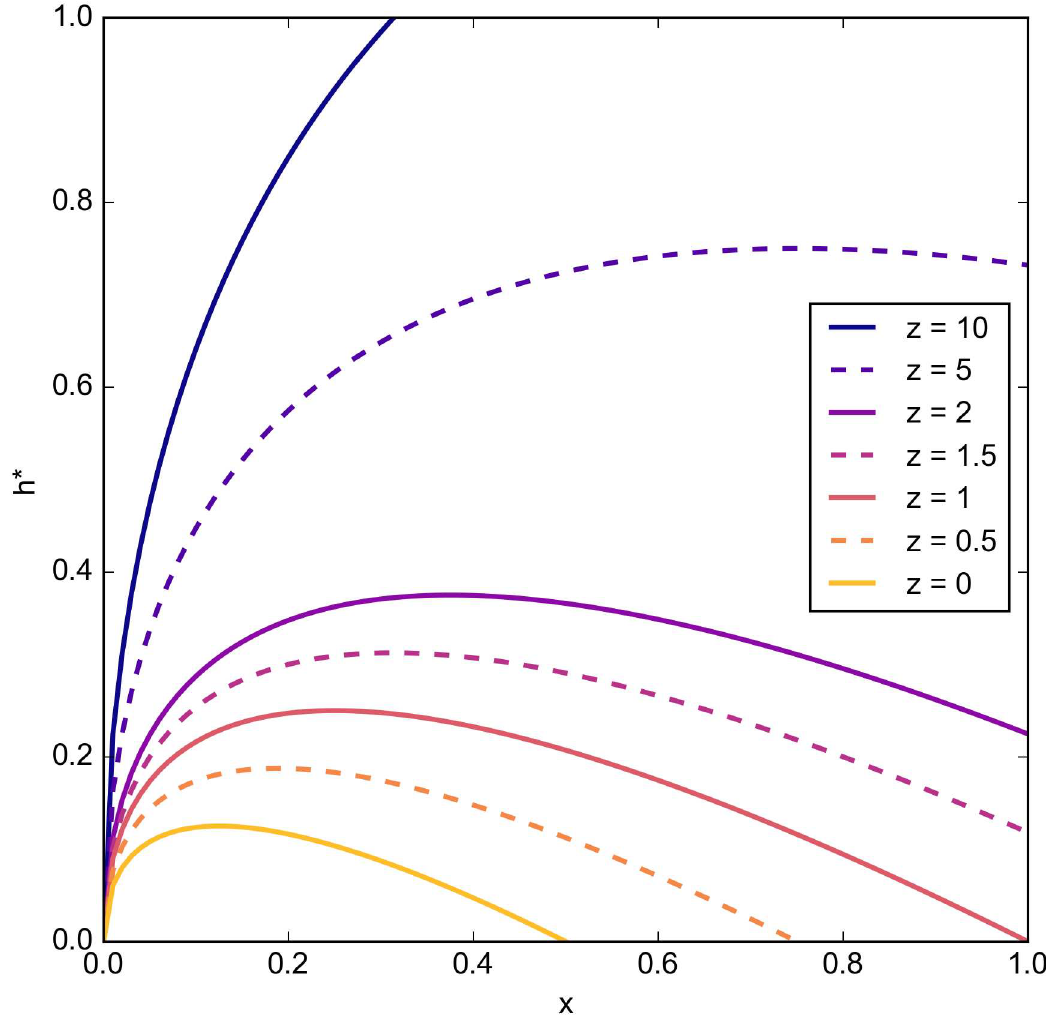
Fig 1. Optimal help values, h * Eq (10), with respect to x 2 [0, 1] for various z values. We use the default values of m = 1, k = 0, and N sufficiently large, and we note that increasingvalues of m only scale the resulting curves, without changingtheir qualitative behaviour.Similarly, increasingvalues of k simply directly reduce the amount of optimal active help